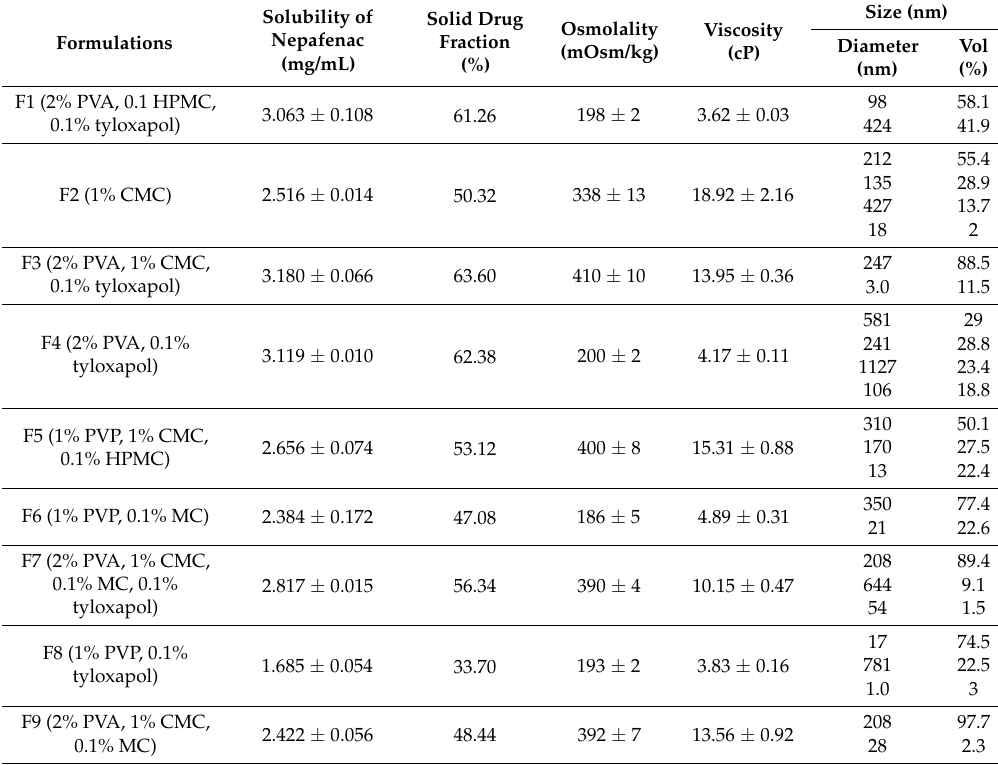
Table 6. Characteristics of 0.5% ( w / v ) eye drop formulations including solubility of nepafenac, proportion of solid drug fraction, osmolality, viscosity and aggregate